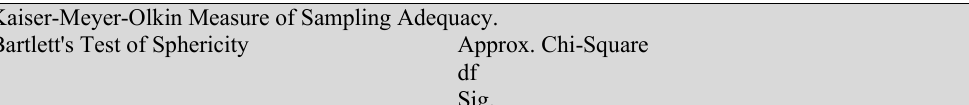
KMO and Bartlett's Test Kaiser-Meyer-Olkin Measure of Sampling Adequacy.